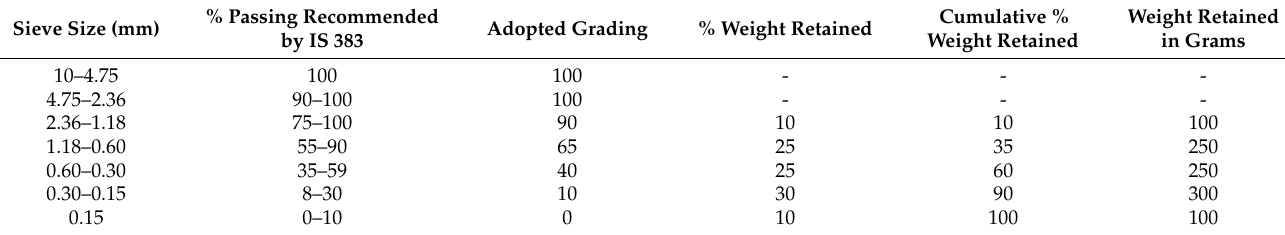
Table 2. Ratios of various sand fraction sizes conforming Zone II.